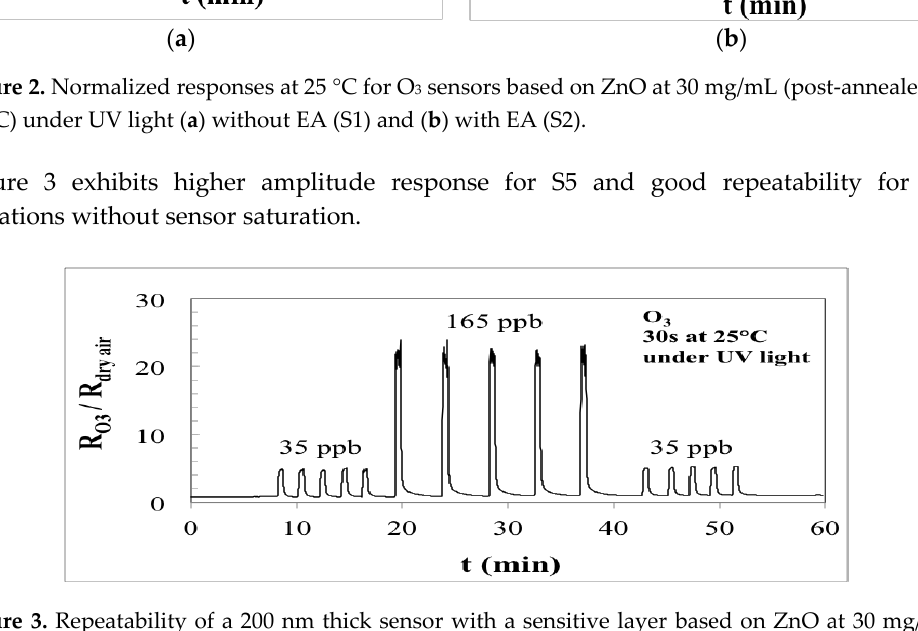
Figure 3. Repeatability of a 200 nm thick sensor with a sensitive layer based on ZnO at 30 mg/mL with EA (S5) and post-annealed at 80 °C, working at 25 °C under continuous UV illumination for 35 ppb and 165 ppb of O 3 .